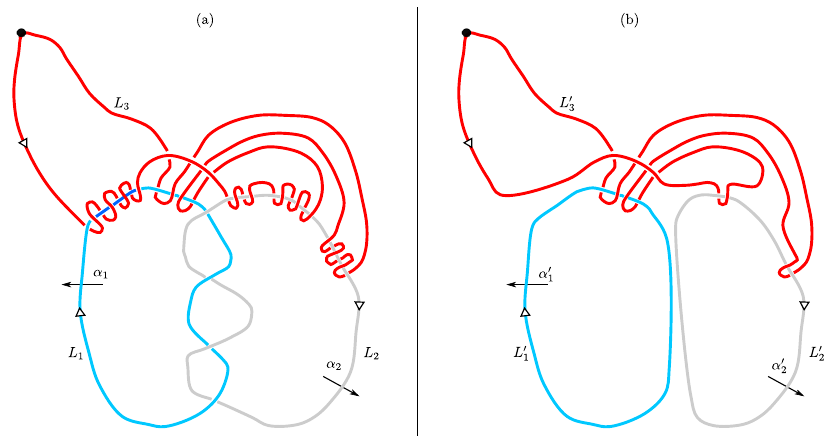
Fig. 12 Classi fi cation of three-component links. The bicoloring is ignored for simplicity. a The linking number between L 1 and L 2 is − 2, and the loop L 3 corresponds to an element of form α 1 α 3 times. For the resulting link, the pairwise linking numbers are 0, and the triple linking number μ (123) is 1, so the link is homotopic to the Borromean rings.